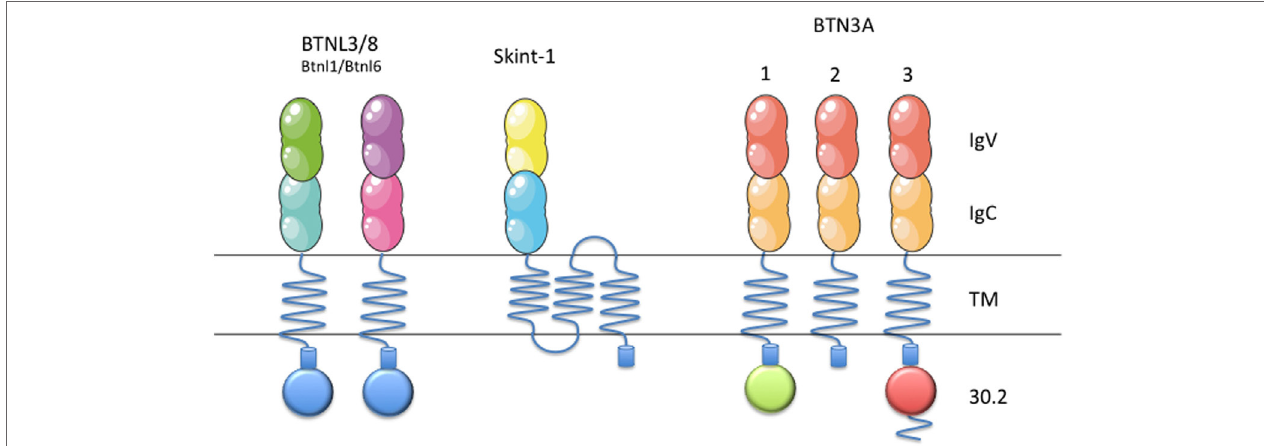
FiGURe 1 | Schematic representation of BTN3, Btnl1, Btnl6, BTNL3, BTNL8, and Skint-1. Schematic representation of BTN/BTNL molecules in mice (Btnl1, Btnl6, and Skint-1) and humans (BTN3, BTNL3, and BTNL8), that have been shown to regulate specific γδ T cell subsets. Each subfamily member contains an extracellular, N-terminal IgV, and a membrane-proximal IgC domain connected to a single-pass transmembrane domain. BTN3A1 and BTN3A3 contain intracellular B30.2 domains, as well as BTNL3 and BTNL8, which is missing in BTN3A2. This figure was created in part using graphics from Servier Medical Art (https://smart. servier.com/) with